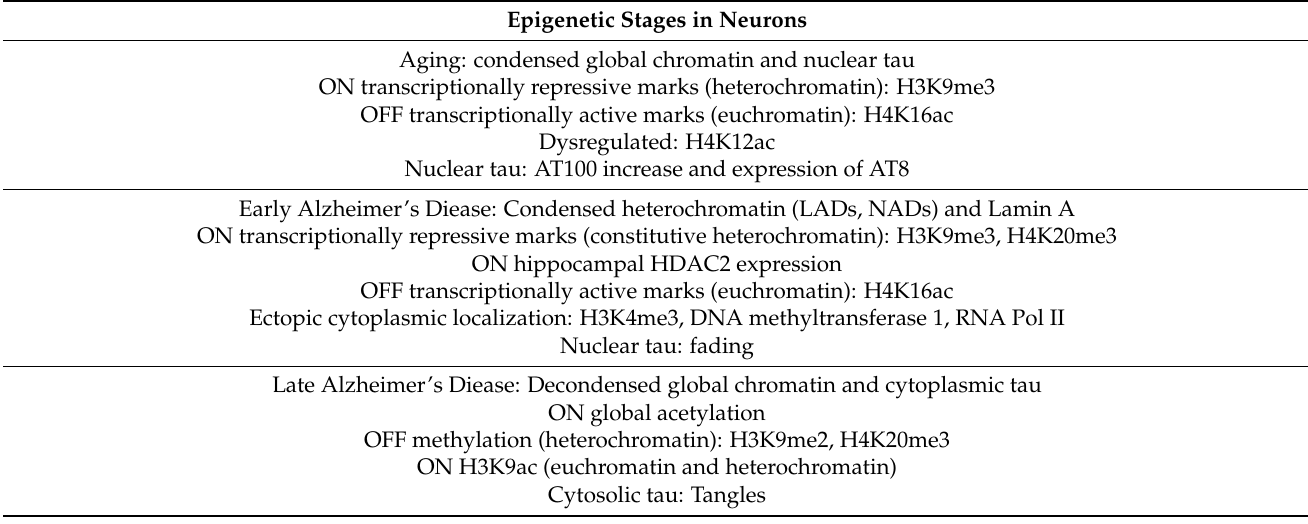
Table 1. Summary of chromatin and tau modifications in human CA1 pyramidal neurons through aging and AD evolution. Two epigenetic landscapes are defined for AD, considering an early and a late